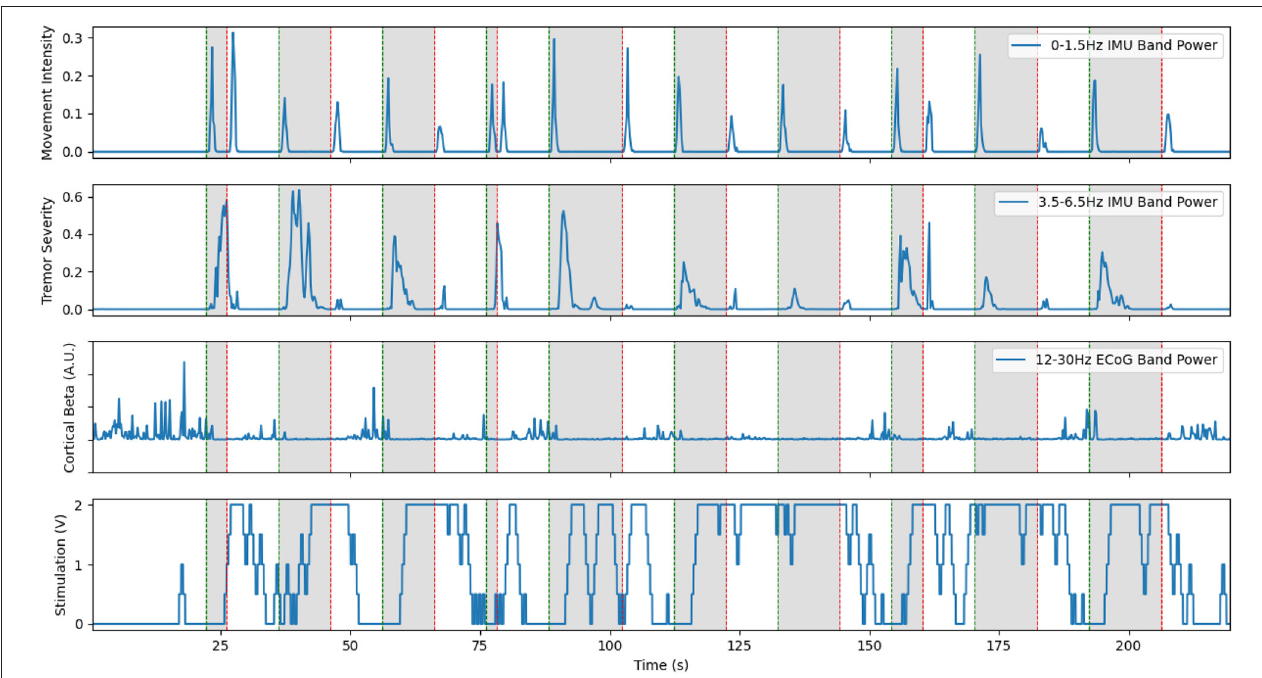
FIGURE 5 | Representative example of cortical LFP driven aDBS using the beta desynchronization classifier approach with Patient 1. The inclusion of a separate classifier for the on and off states allows stimulation to stay on through the duration of prompted movements, shown in gray. However, large delays in this distributed system still led to large burst of tremor near the start of movement. Limited resolution of the LFP recordings occasionally lead to the classifier incorrectly switching on or off, as seen at 15 s and during the prompted movement at 100 s. This is a re-illustration of the results in Houston et al.